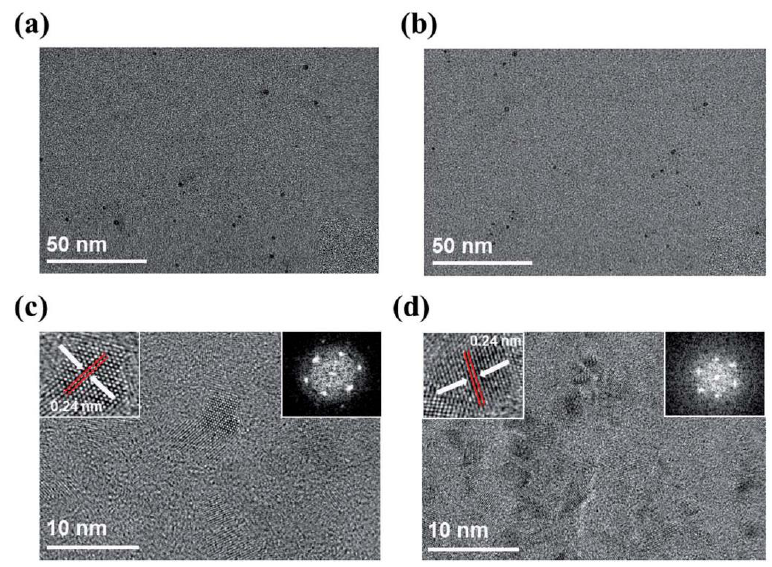
Figure 34. ( a ) HRTEM images of ( a , c ) on-GQDs and ( b , d ) off-GOQDs